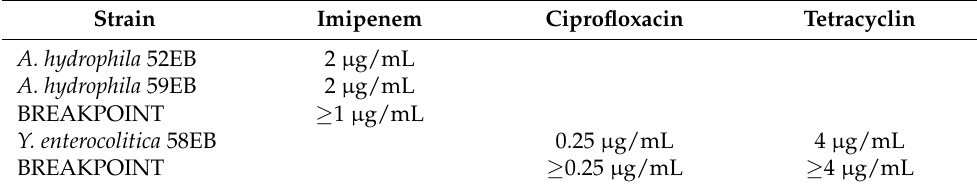
Table 5. MIC values for A. hydrophila and Y. enterocolitica strains and Break Point values. Strain